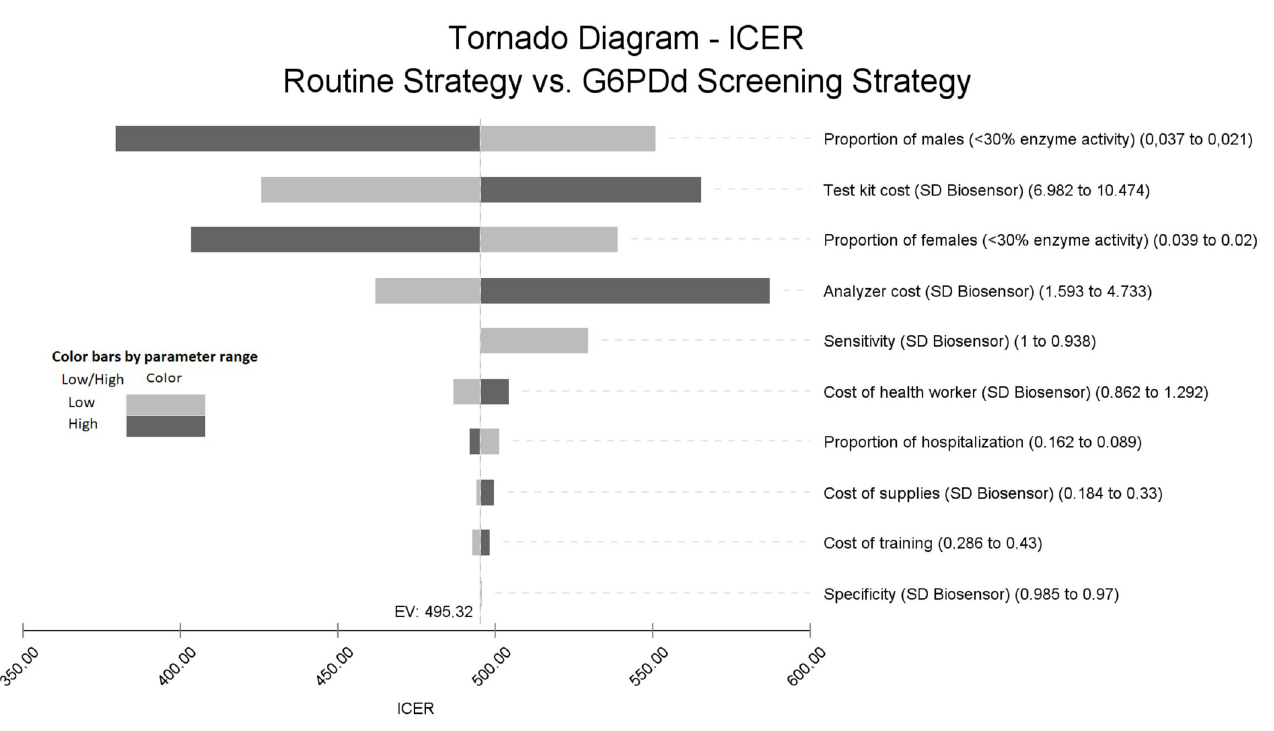
Fig 2. Incremental Cost-effectiveness Ratio (ICER) Tornado diagram for univariate sensitivity analysis of routine strategy versus G6PDd screening strategy, based on the individual impact of each of the variables on the ICER. The vertical line denotes the base-case expected value (EV).